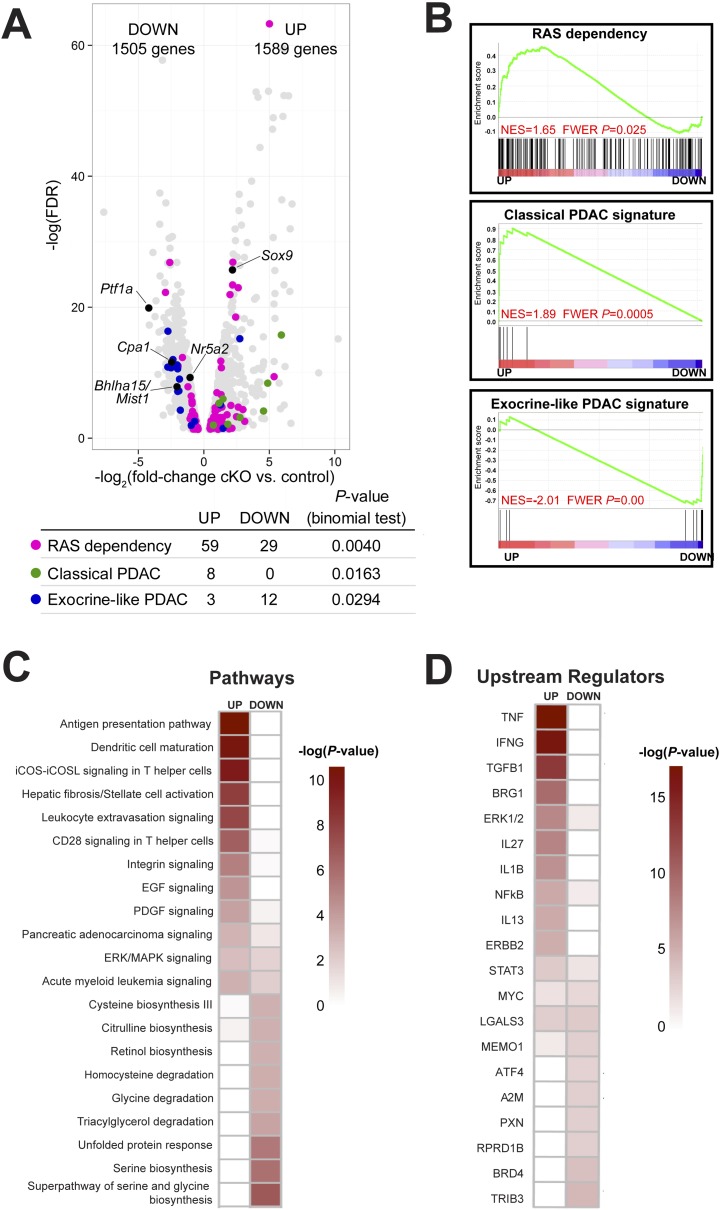
Ptf1a suppresses fibroinflammatory pathways and oncogenic KRAS associated gene signatures.(A) Volcano plot showing differentially expressed genes (false discovery rate [FDR] <0.05; gray) in Ptf1a cKO pancreata, relative to control. Individual genes are labeled and highlighted in black. Genes belonging to signatures characteristic of RAS dependency, classical and exocrine-like pancreatic ductal adenocarcinoma (PDAC) are highlighted in pink, green, and blue, respectively. Table below indicates p-values from binomial test for enrichment of gene signatures within up- or down-regulated genes. (B) Gene Set Enrichment Analysis (GSEA) enrichment plots of differentially expressed genes between Ptf1a cKO and control indicating positive enrichment of RAS dependency and classical PDAC signatures and negative enrichment of exocrine-like PDAC signature genes. (C, D) Ingenuity Pathway Analysis (IPA, Qiagen Redwood City, www.qiagen.com/ingenuity) was used to identify differentially expressed pathways and upstream regulators in Ptf1a cKO pancreata. (C) Heat map of pathways that are significantly increased and decreased upon Ptf1a deletion. (D) Heat map of upstream pathways and regulators predicted to drive the observed changes in gene expression. Color scale is indicative of the -log p-value (significance). All analyses are based on a ±2.0-fold expression threshold. Full details of the data set and analyses can be found in the supplementary data files.